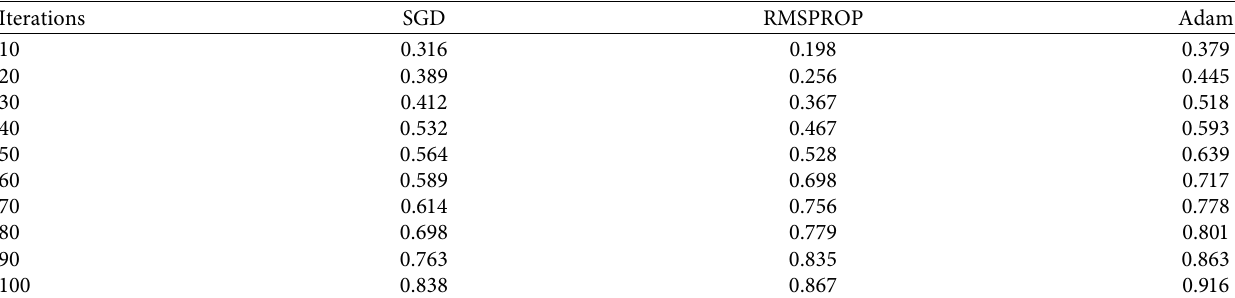
Table 2: The relationship between optimizer and recognition rate in UCF-101